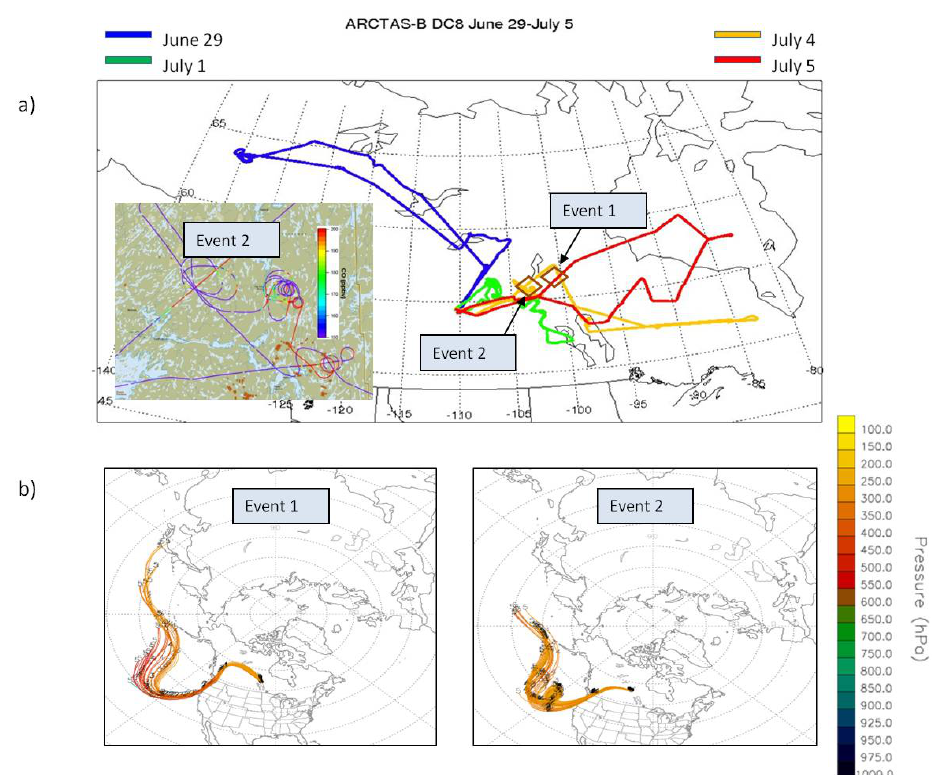
Fig. 1. ARCTAS B research flight paths taken by the NASA DC-8 between 29 June and 5 July (a) color-coded by flight date. Event 1 and 2 locations are shown by diamonds. Inset shows the flight track near event 2, color-coded by CO mixing ratios. (b) 5-day back trajectories for events 1 and 2,